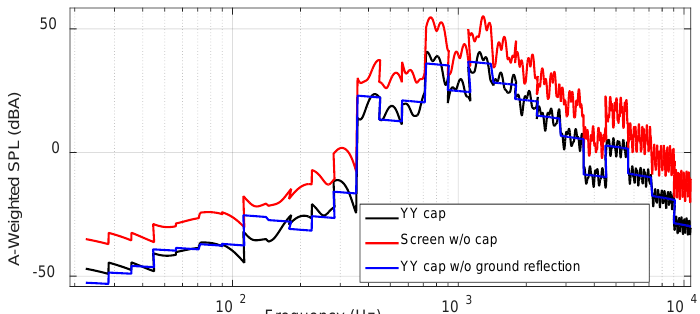
Figure 27. A-weighted SPL spectrum in 1 Hz bands in Configuration 3 (Ambulance–Person) for the ‘YY’ cap with and without ground reflection. The screen barrier SPL spectrum is shown as a reference.